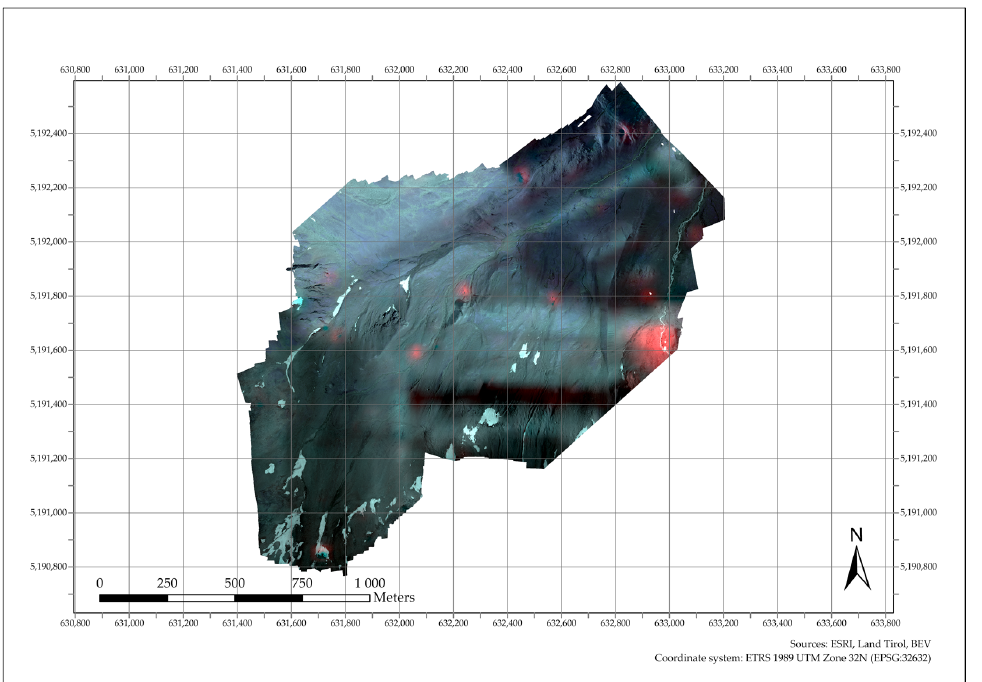
Figure 2. The OCN orthomosaic with different illumination conditions. Red areas are interpreted as artifacts due to illumination conditions.